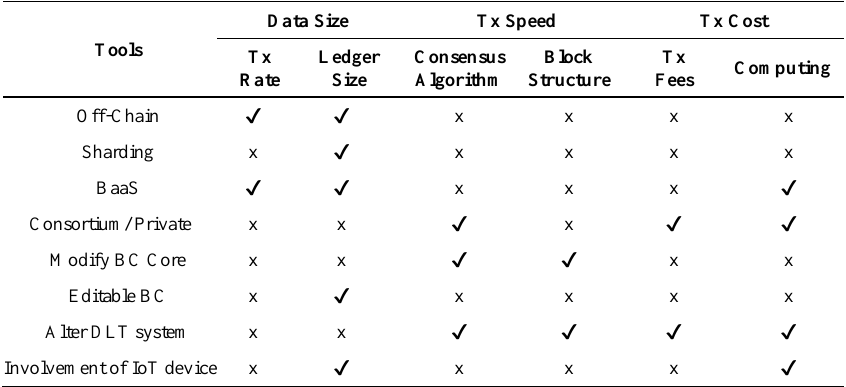
Table 3. Tools' impacts on Blockchain